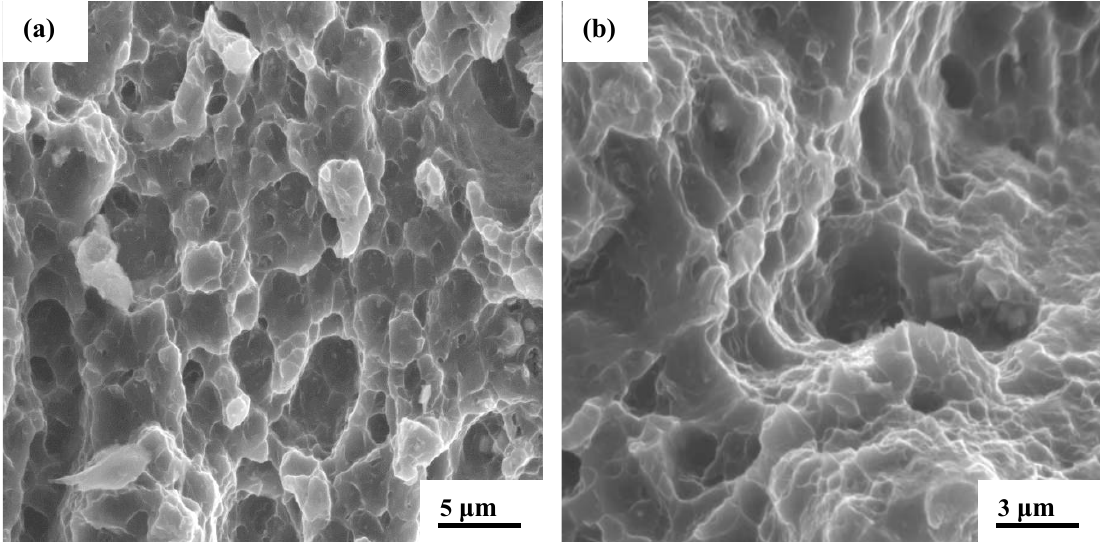
Figure 8. Scanning electron micrographs of the high cycle fatigue fracture surface of O containing 1.5 wt pct nickel deformed at maximum cyclic stress of AZ31 + Al 2 3 183.14 MPa at load ratio of 0.1, fatigue life of 15,009 cycles, showing the following: ( a ) The region of overload showing a population of dimples interdispersed with fine microscopic voids and ( b ) At the “heart” of the overload region reveals a noticeable quantity of shallow dimples reminiscent of locally operating ductile failure